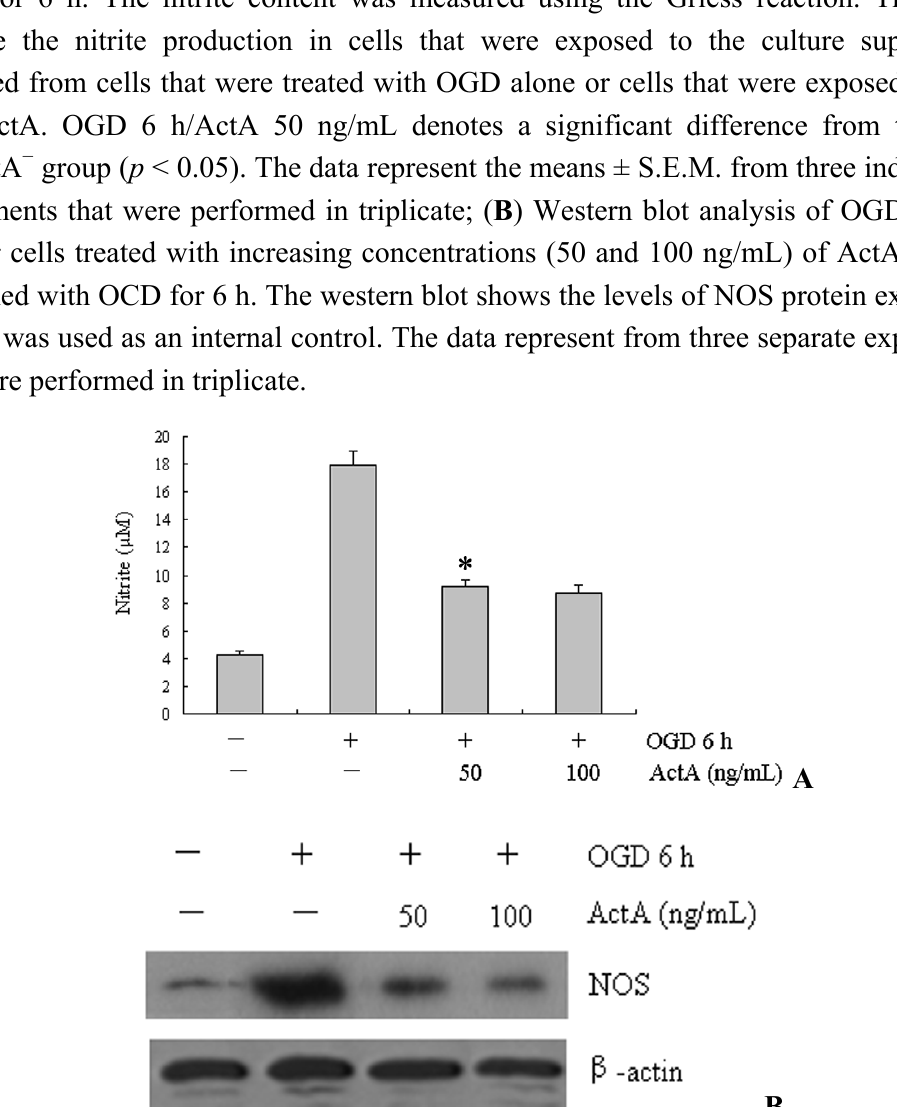
Figure 5. Effect of ActA on oxidative stress in OGD for 6 h-induced PC12 cells. ( A ) Cells were OGD-induced by incubation with 50 or 100 ng/mL of ActA for 24 h combined